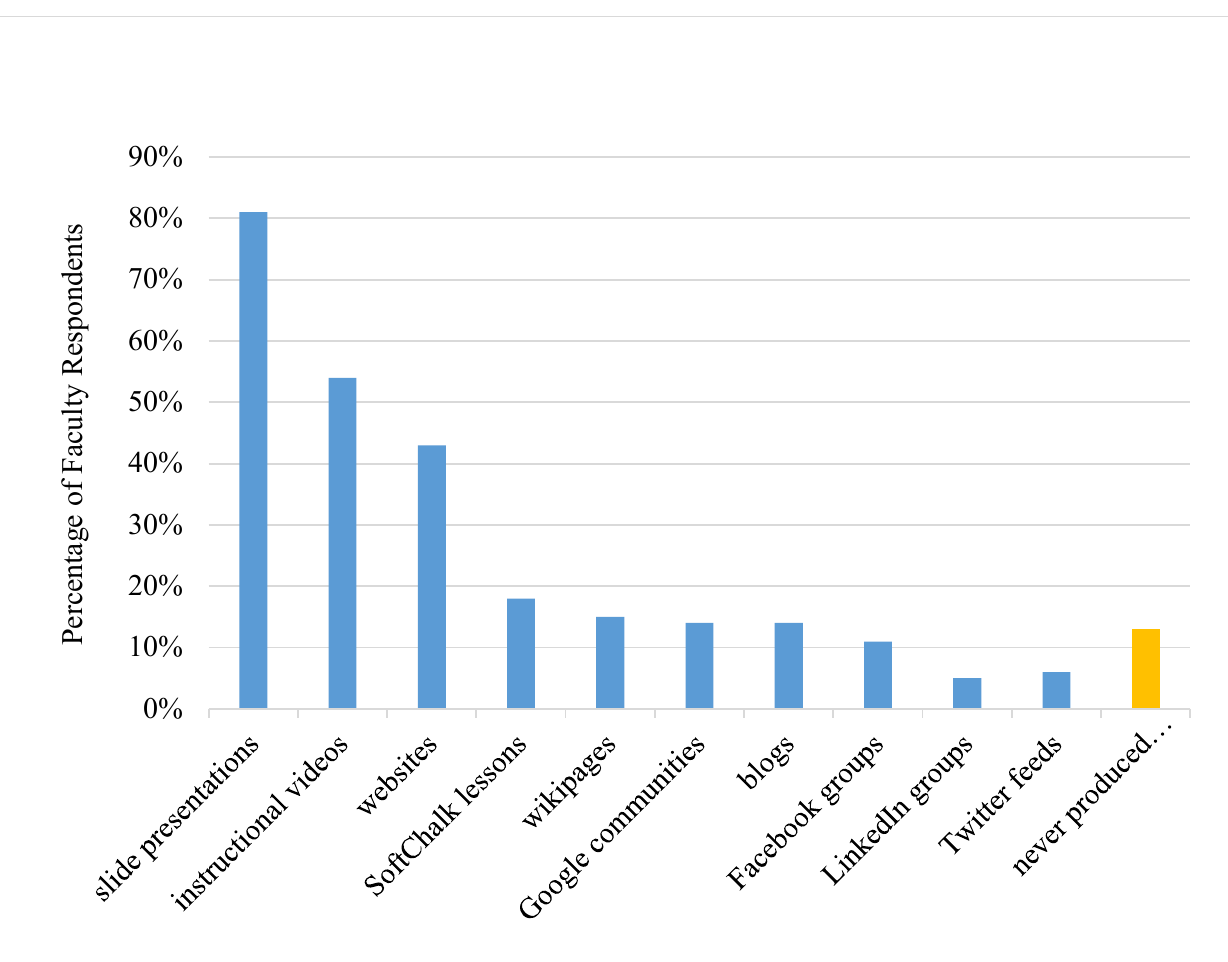
Figure 3 . Types of technology tools faculty